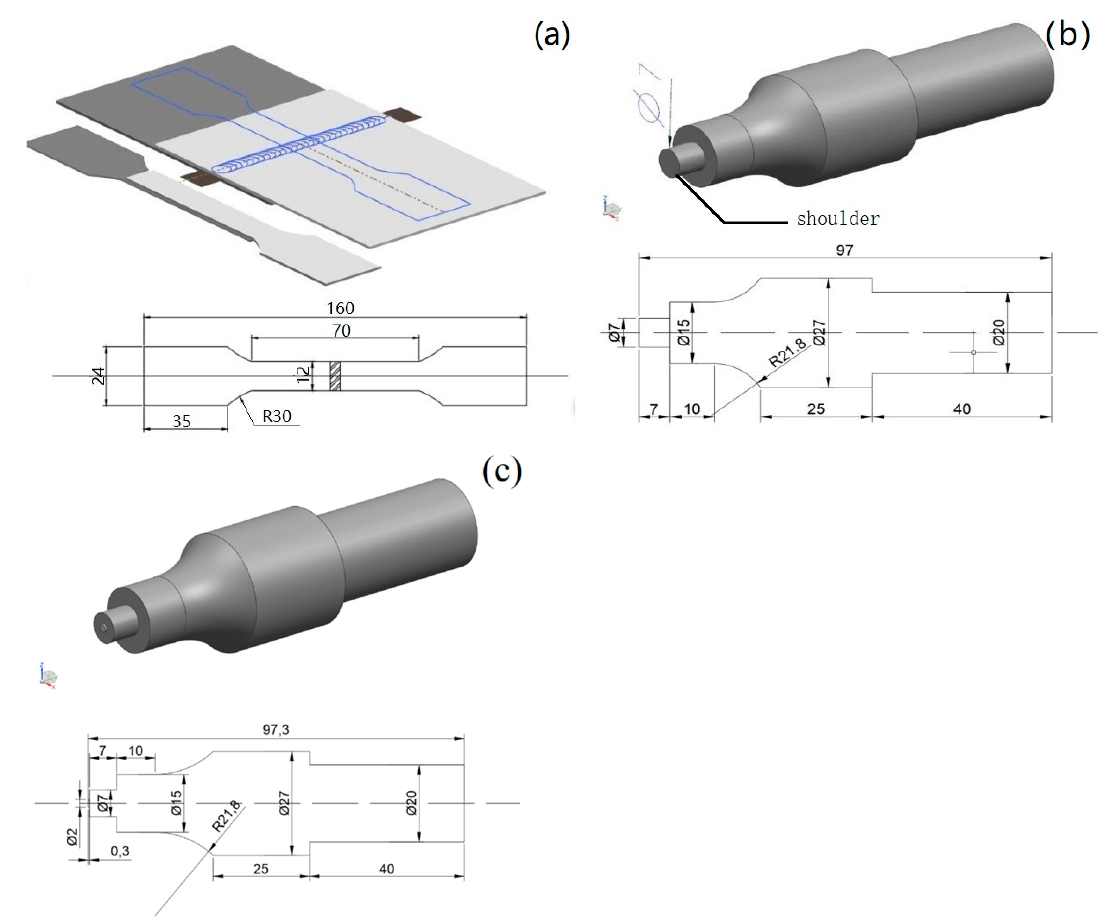
Figure 1. ( a ) Welding schematic diagram, ( b ) welding tool without pin and ( c ) welding tool with 0.3 mm pin.